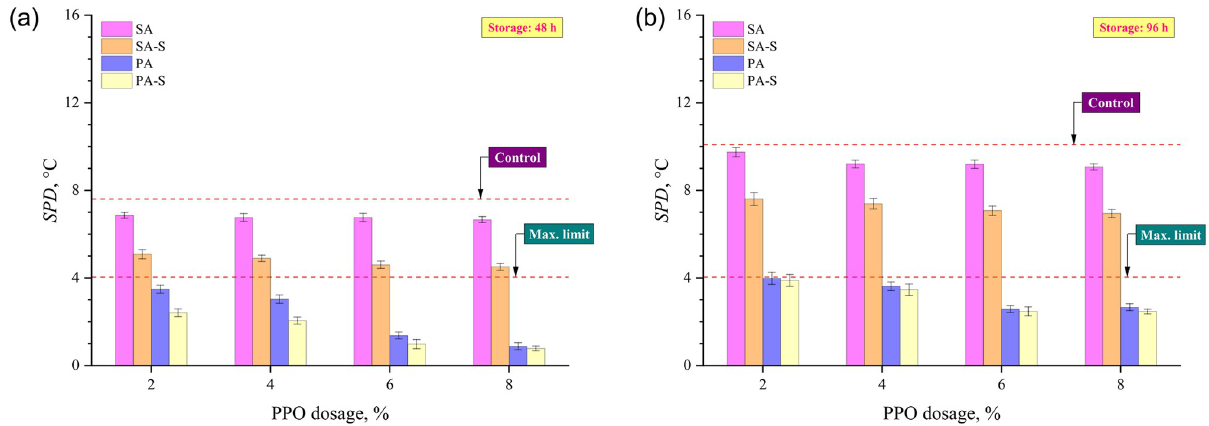
Fig 5. Softening point difference results after (a) 48 h and (b) 96 h of thermal storage.